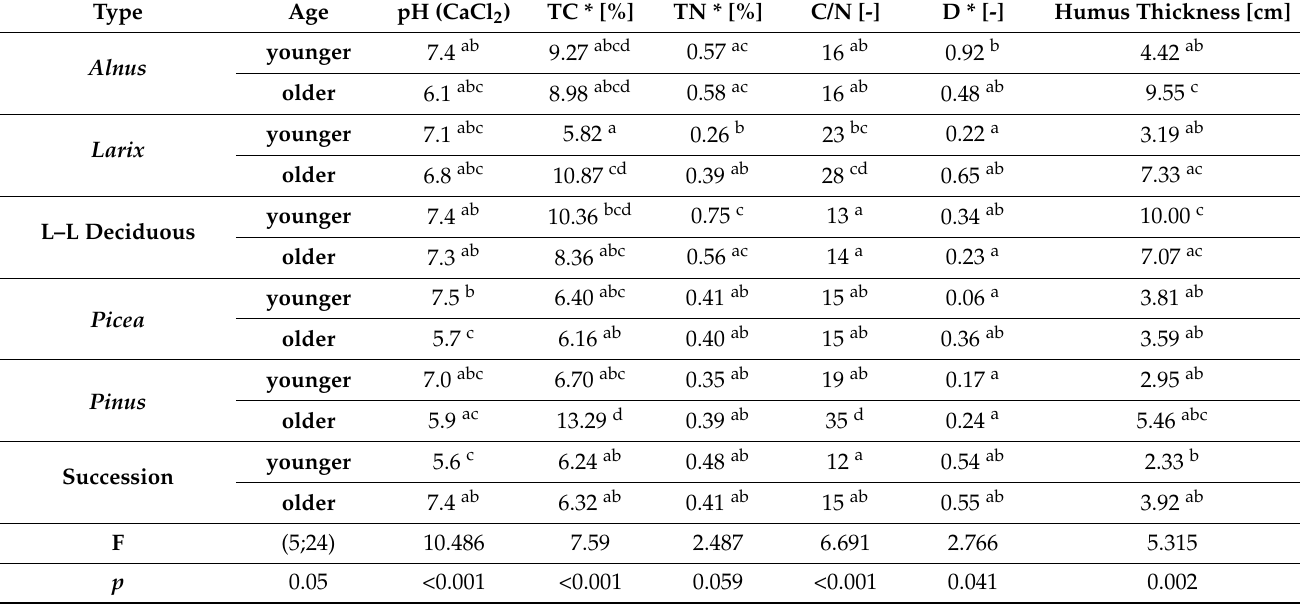
Table 1. Results of factorial ANOVA for soil properties. Letters indicate significant differences based on post hoc Tukey